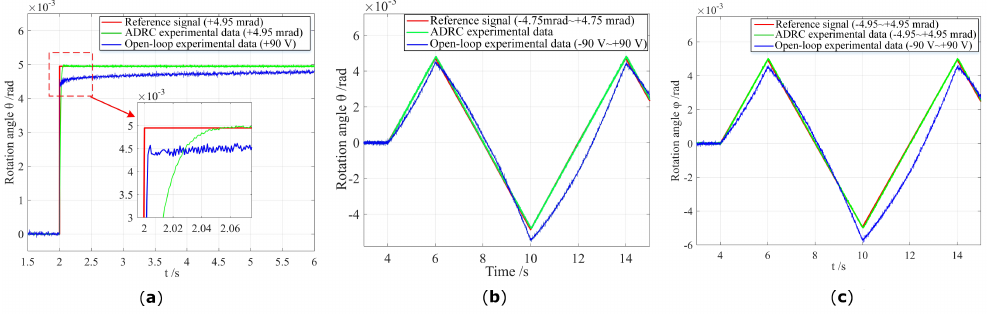
Figure 10. Attitude decoupling control for the 3-DOF flexible piezoelectric nano-positioning stage.